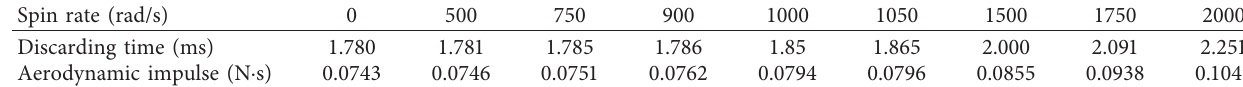
Table 5: Discarding characteristic under different spin rates.